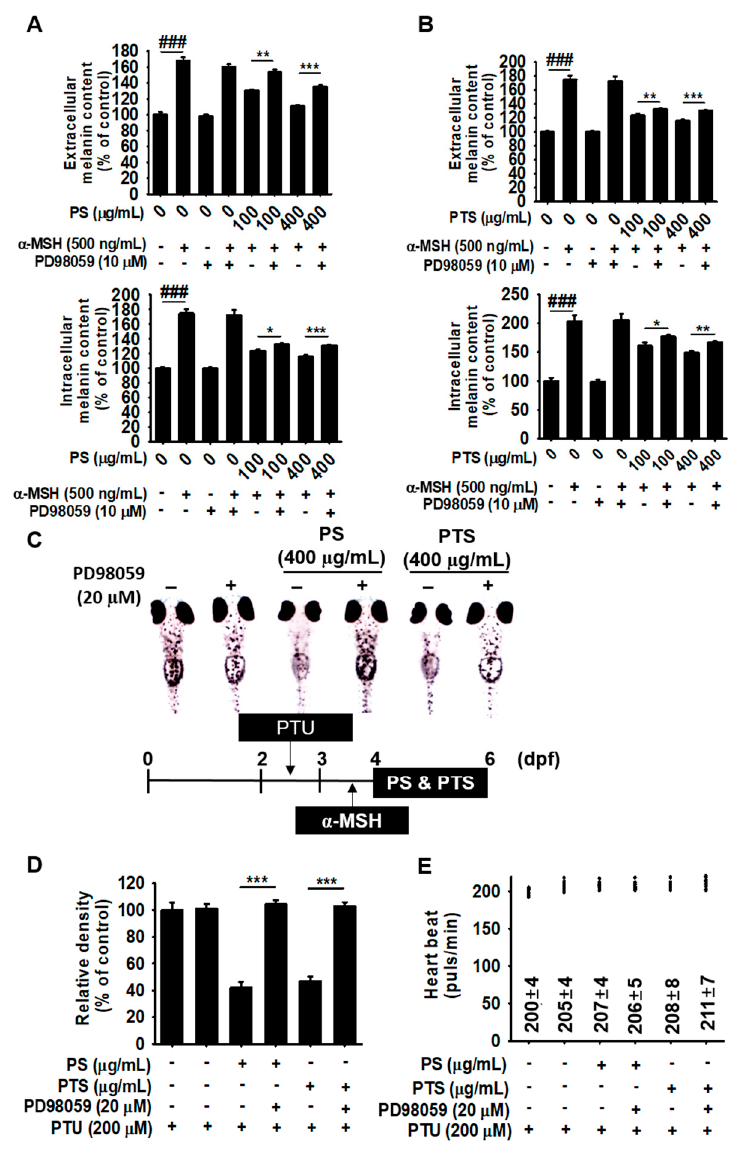
Figure 7. The ERK signaling pathway inhibits melanogenesis in PS- and PTS-treated B16F10 cells and zebrafish larvae. ( A , B ) B16F10 cells were treated with α -MSH (500 ng / mL) in the presence of PS or PTS (100 µ g / mL and 400 µ g / mL) for 72 h after pretreatment with PD98059 (10 µ M). Extracellular (top) and intracellular (bottom) melanin contents were measured (A: PS-treated; B; PTS-treated). ( C ) Zebrafish at 2 dpf ( n = 20) were treated with PTU (200 µ M) for 24 h and then with α -MSH (1 µ g / mL) for 48 h. Next, the medium was replaced with PD98059 (20 µ M) for 2 h, and then the fish were treated with PS (400 µ g / mL) or PTS (400 µ g / mL) for 48 h. ( D ) Pigmentation in zebrafish was observed under an Olympus microscope (40 × ) and relative density was calculated by the Image J software. ( E ) Average heart rate in zebrafish larvae ( n = 20) was measured to assess the toxicity of the extracts. Data are reported as the mean ± SEM of three independent experiments ( n = 3). ### p < 0.001 vs . untreated group; * p < 0.05, ** p < 0.01 and *** p < 0.001 vs . α -MSH-stimulated group (A and B) and vs . PTU + PT or PTS group (D).